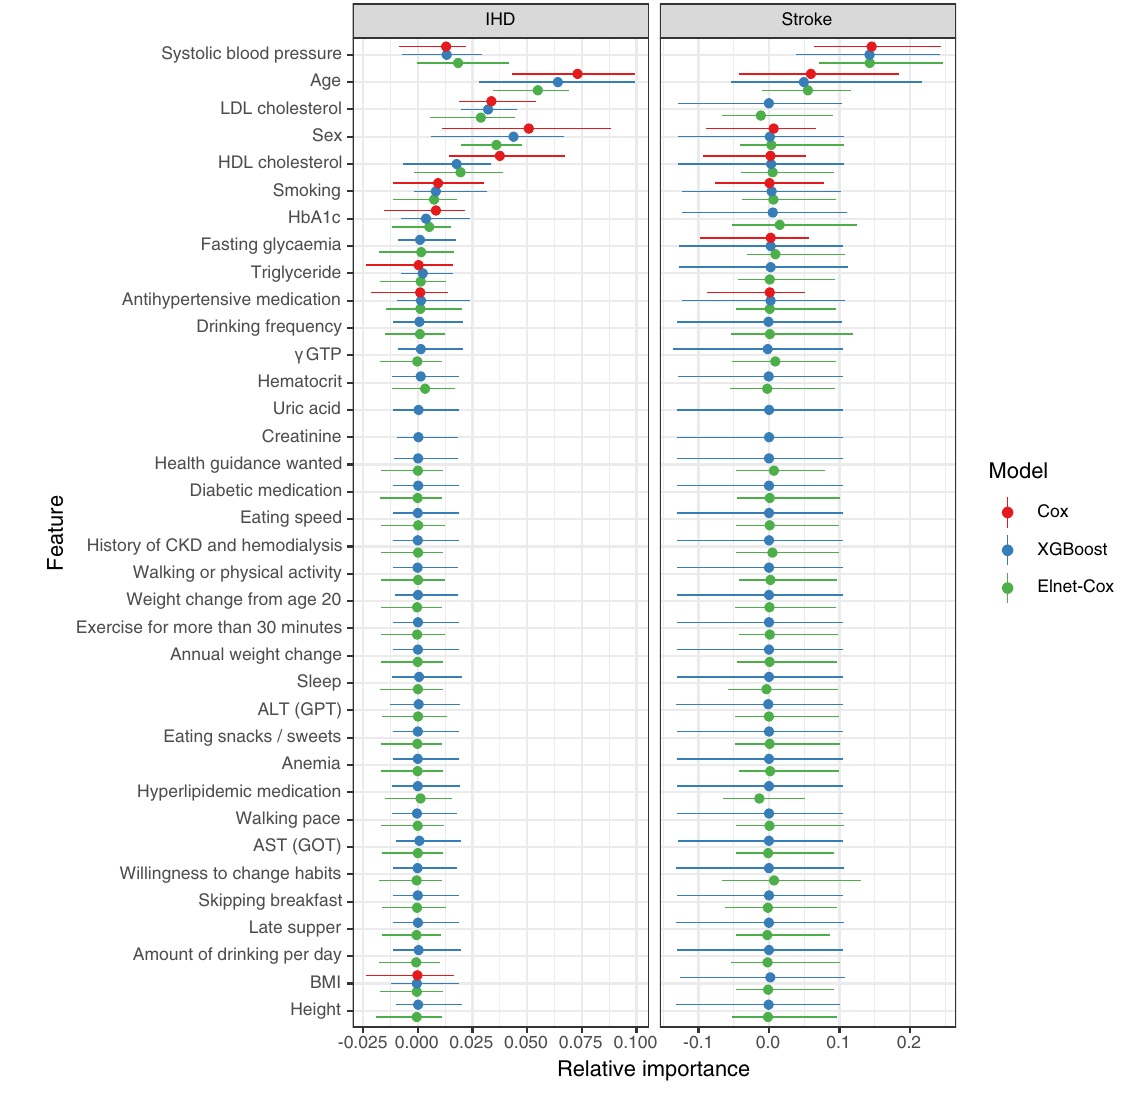
Fig. 5 Feature importance for IHD and stroke models AST: Aspartate transaminase; ALT: Alanine transaminase; BMI: Body mass index; CKD: Chronic kidney disease; Cox: Cox proportional- hazards model; HbA 1c : Glycosalted hemoglobin; GPT: Glutamate pyruvate transaminase; GOT: Glutamate oxalacetate transaminase; HDL: High-density lipoprotein; LDL: Low-density lipoprotein; XGBoost: Extreme gradient boost. Feature was arranged by the mean importance score accorss the models in descending